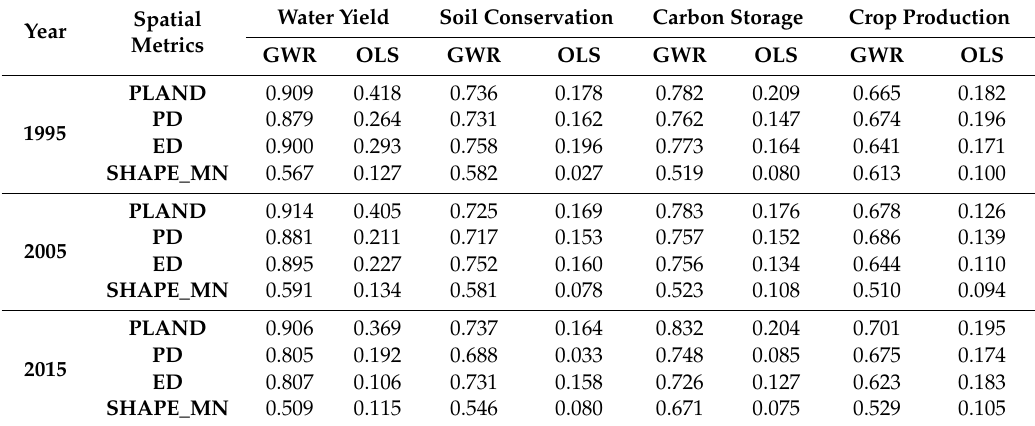
Table 7. Comparison of R 2 between the Geographically Weighted Regression (GWR) and Ordinary Least Squares (OLS) models.